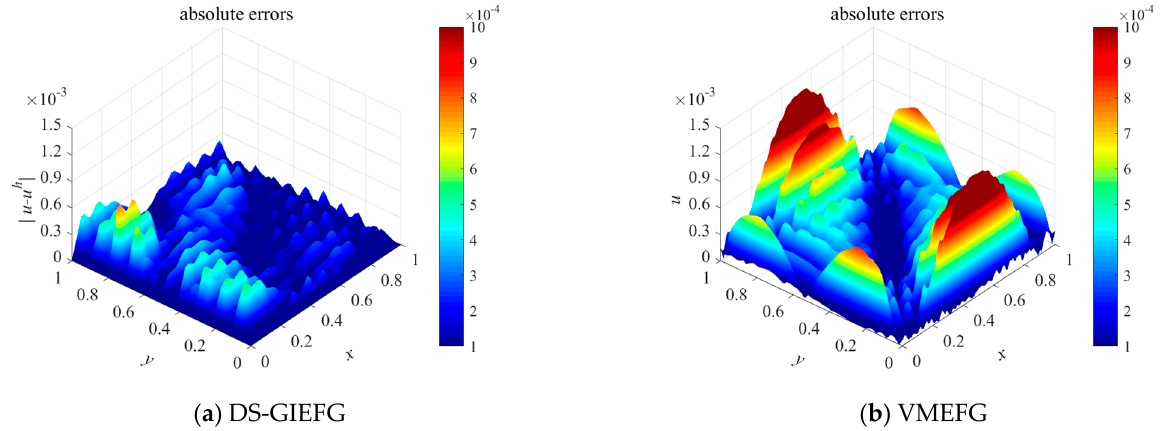
Figure 8. The absolute errors of the VMEFG and DS-GIEFG methods on the whole field under 21 × 21 nodes. When the 17 × 17, 33 × 33, 65 × 65, 129 × 129 node distributions are used, the relative errors of the EFG, VMEFG and DS-GIEFG methods in the lg–lg scale are presented in Figure 9. The results of Ref. [57] are also listed in this figure. Additionally, the correspond- ing CPU time of these methods is plotted in Figure 10. For this example, there is no doubt that the DS-GIEFG method in this paper has higher calculation accuracy and efficiency.